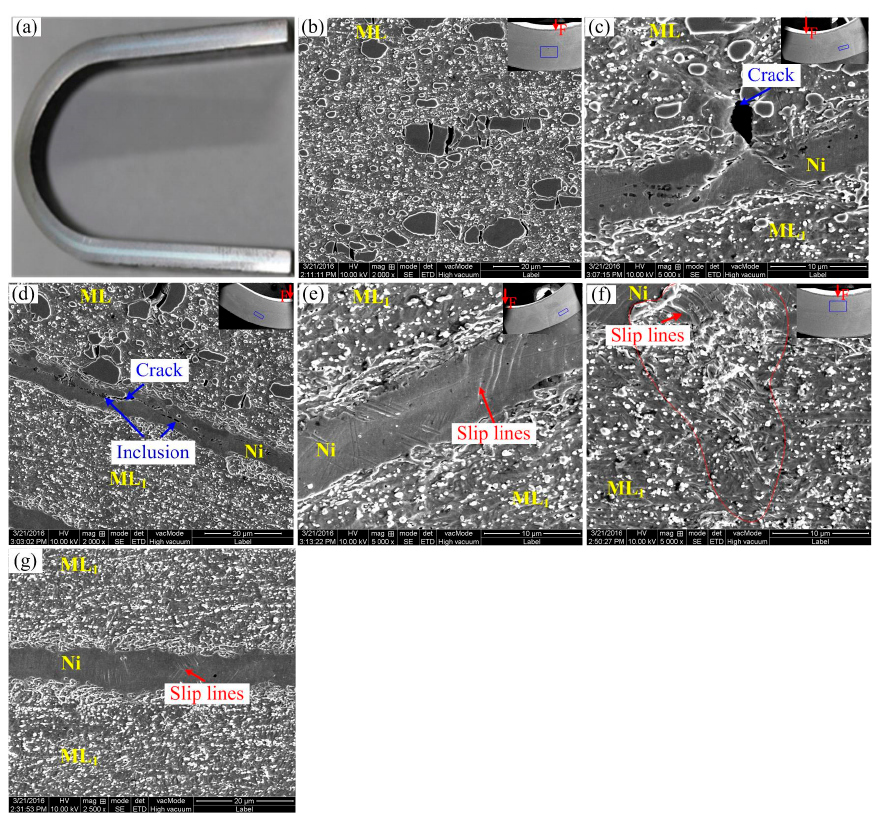
Figure 7. Macro-feature and SEM morphology of the bending specimen after bending to 180 degrees. ( a ) Macroscopic bending morphology, ( b – g ) SEM bending features. ( a ) Macroscopic bending morphology, ( b – g ) SEM bending